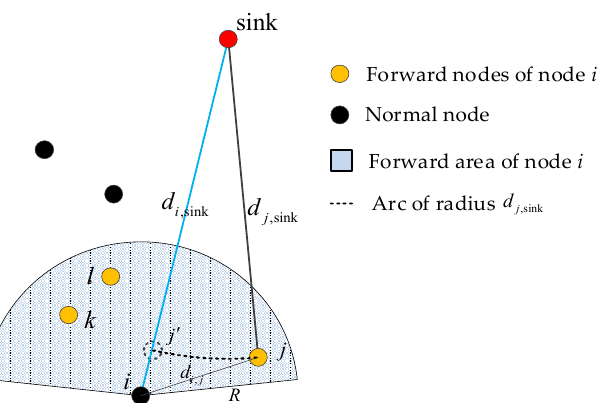
Figure 1. The spatial relationships between the nodes .